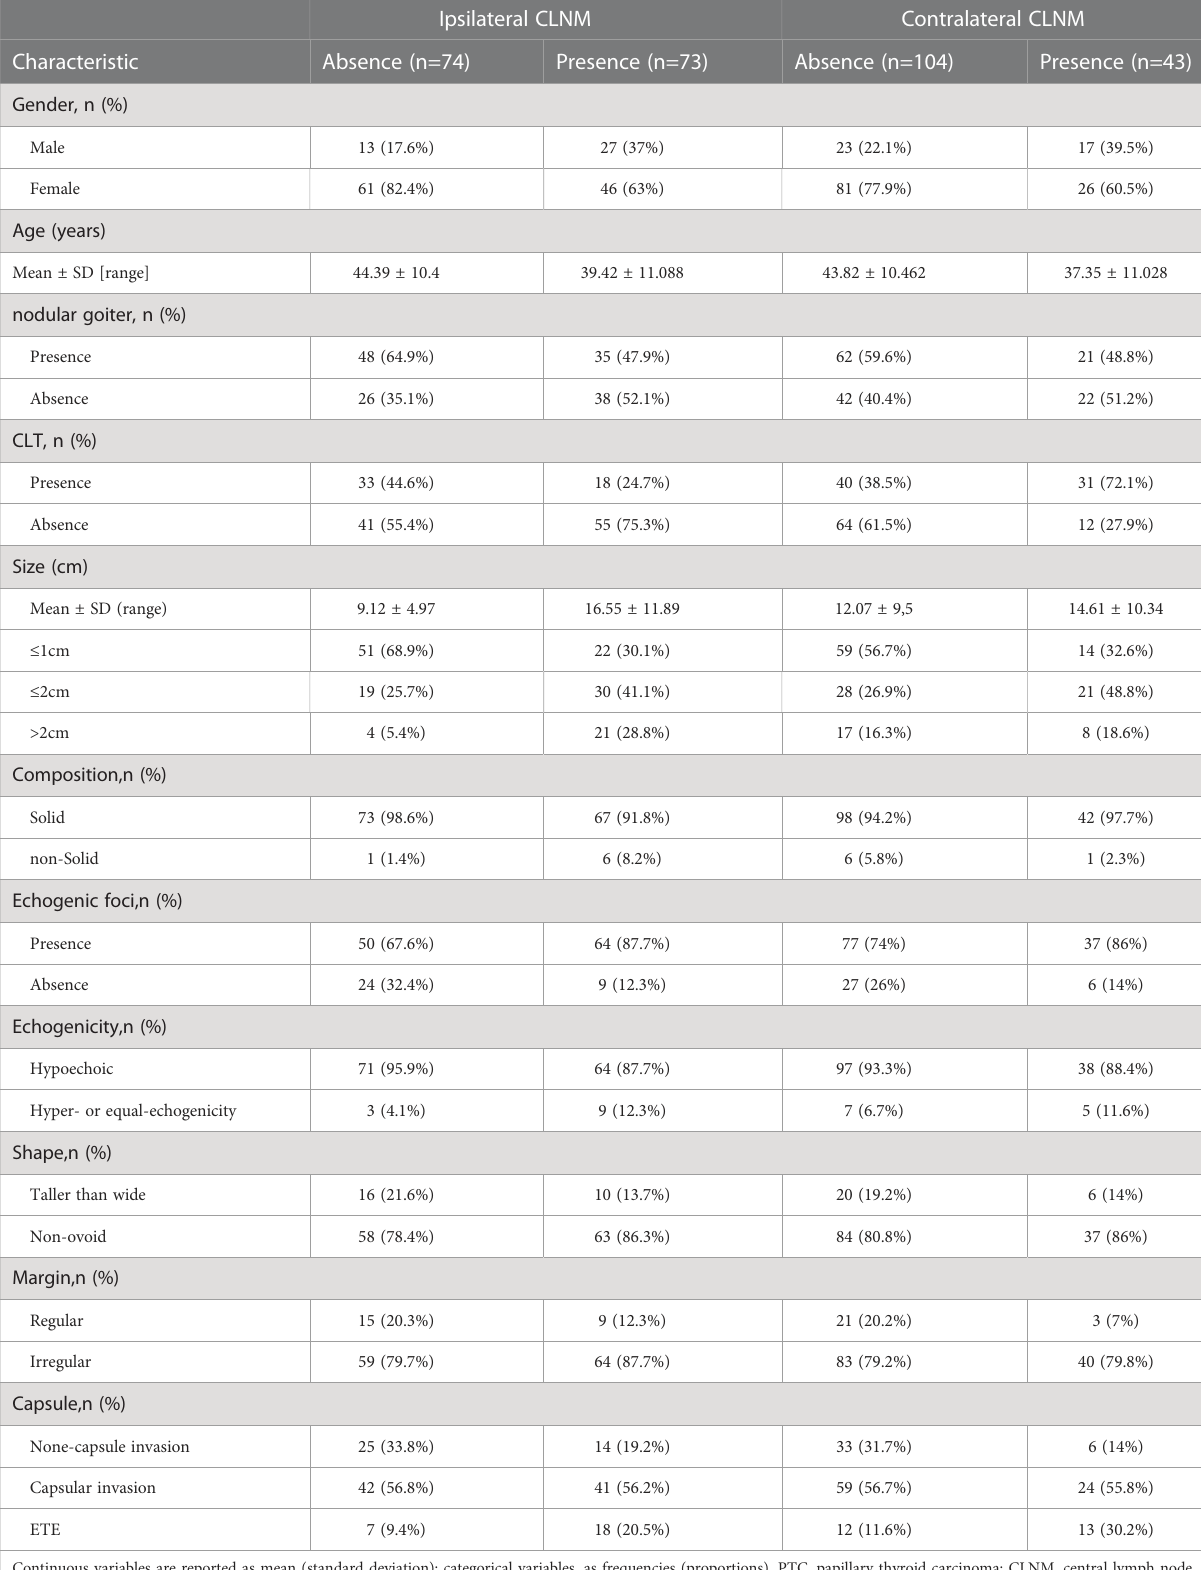
TABLE 1 Baseline characteristics of patients in isthmus-originating papillary thyroid carcinoma